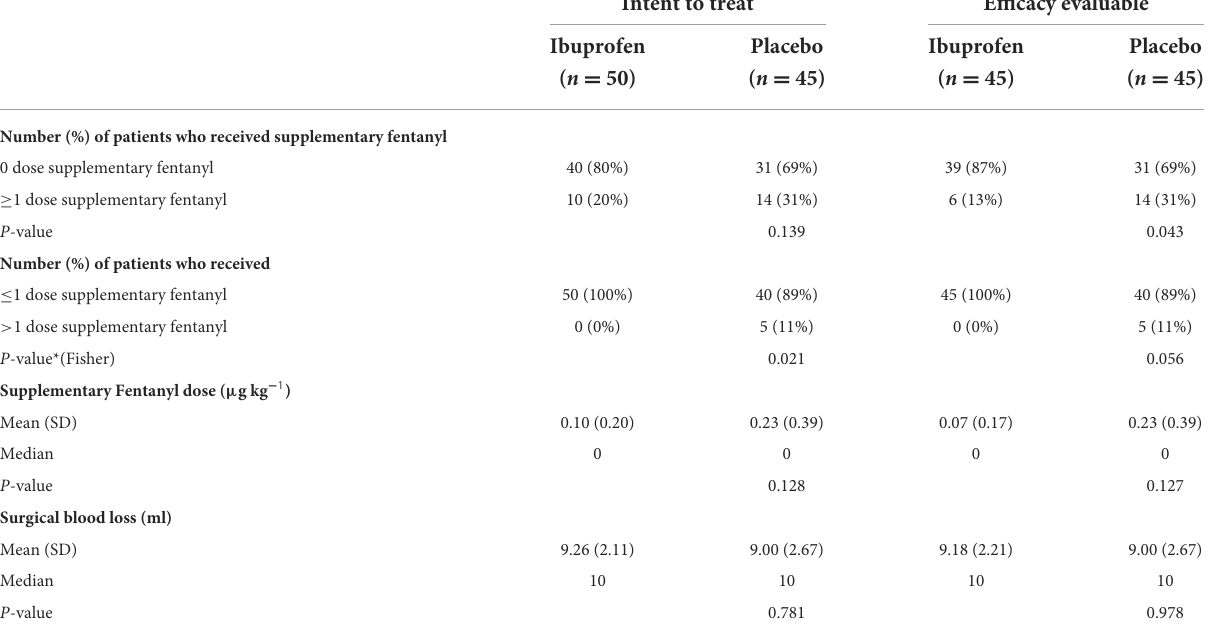
TABLE 2 Postoperative analgesic requirements and intraoperative blood